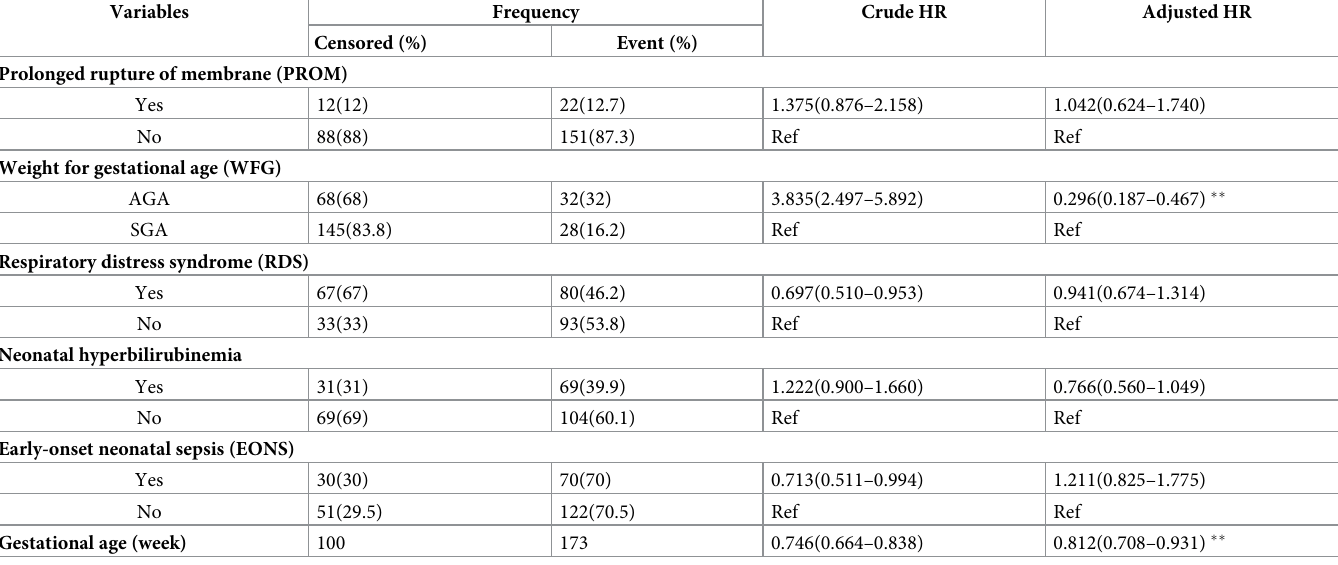
Table 4. Bivariate and multivariate Cox-regression analysis of associated factors of full enteral feeding achievement of infants with birth weight 1000-2000g admit- ted to the neonatal